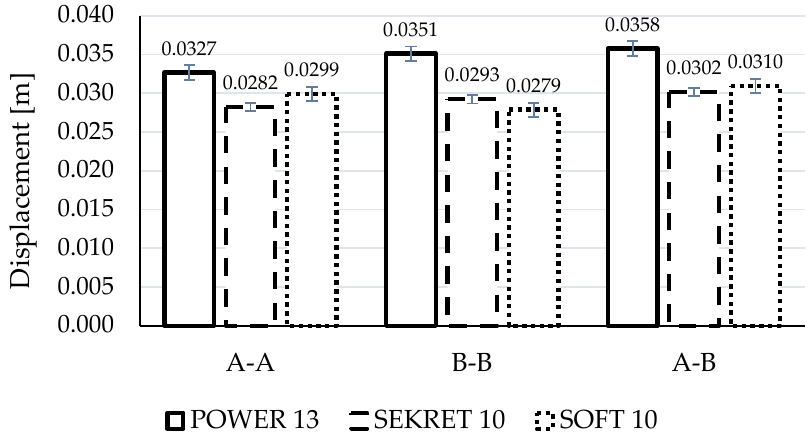
Figure 3. Fabric rigidity in cutting direction: A-A, B-B, A-B.